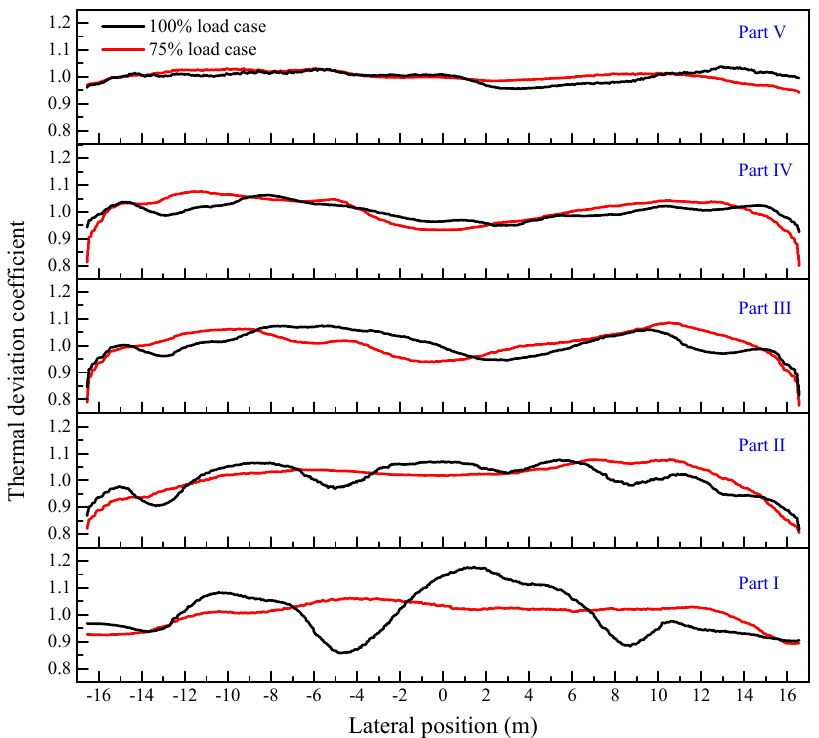
Figure 9. Thermal deviation coefficient of 5 vertical regions.